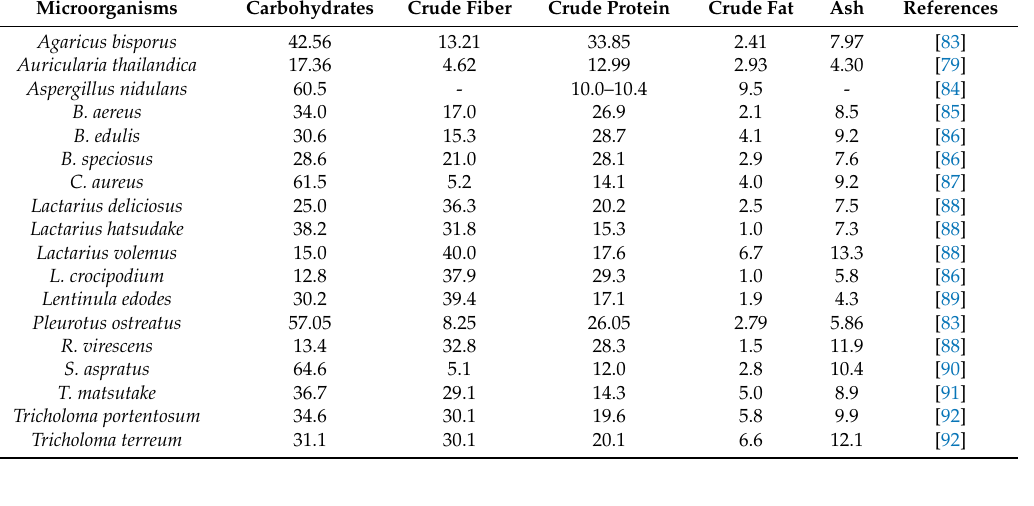
Table 4. Chemical compositions of typical microorganisms, including mushrooms and fungi (the values are presented in dry weight % basis).